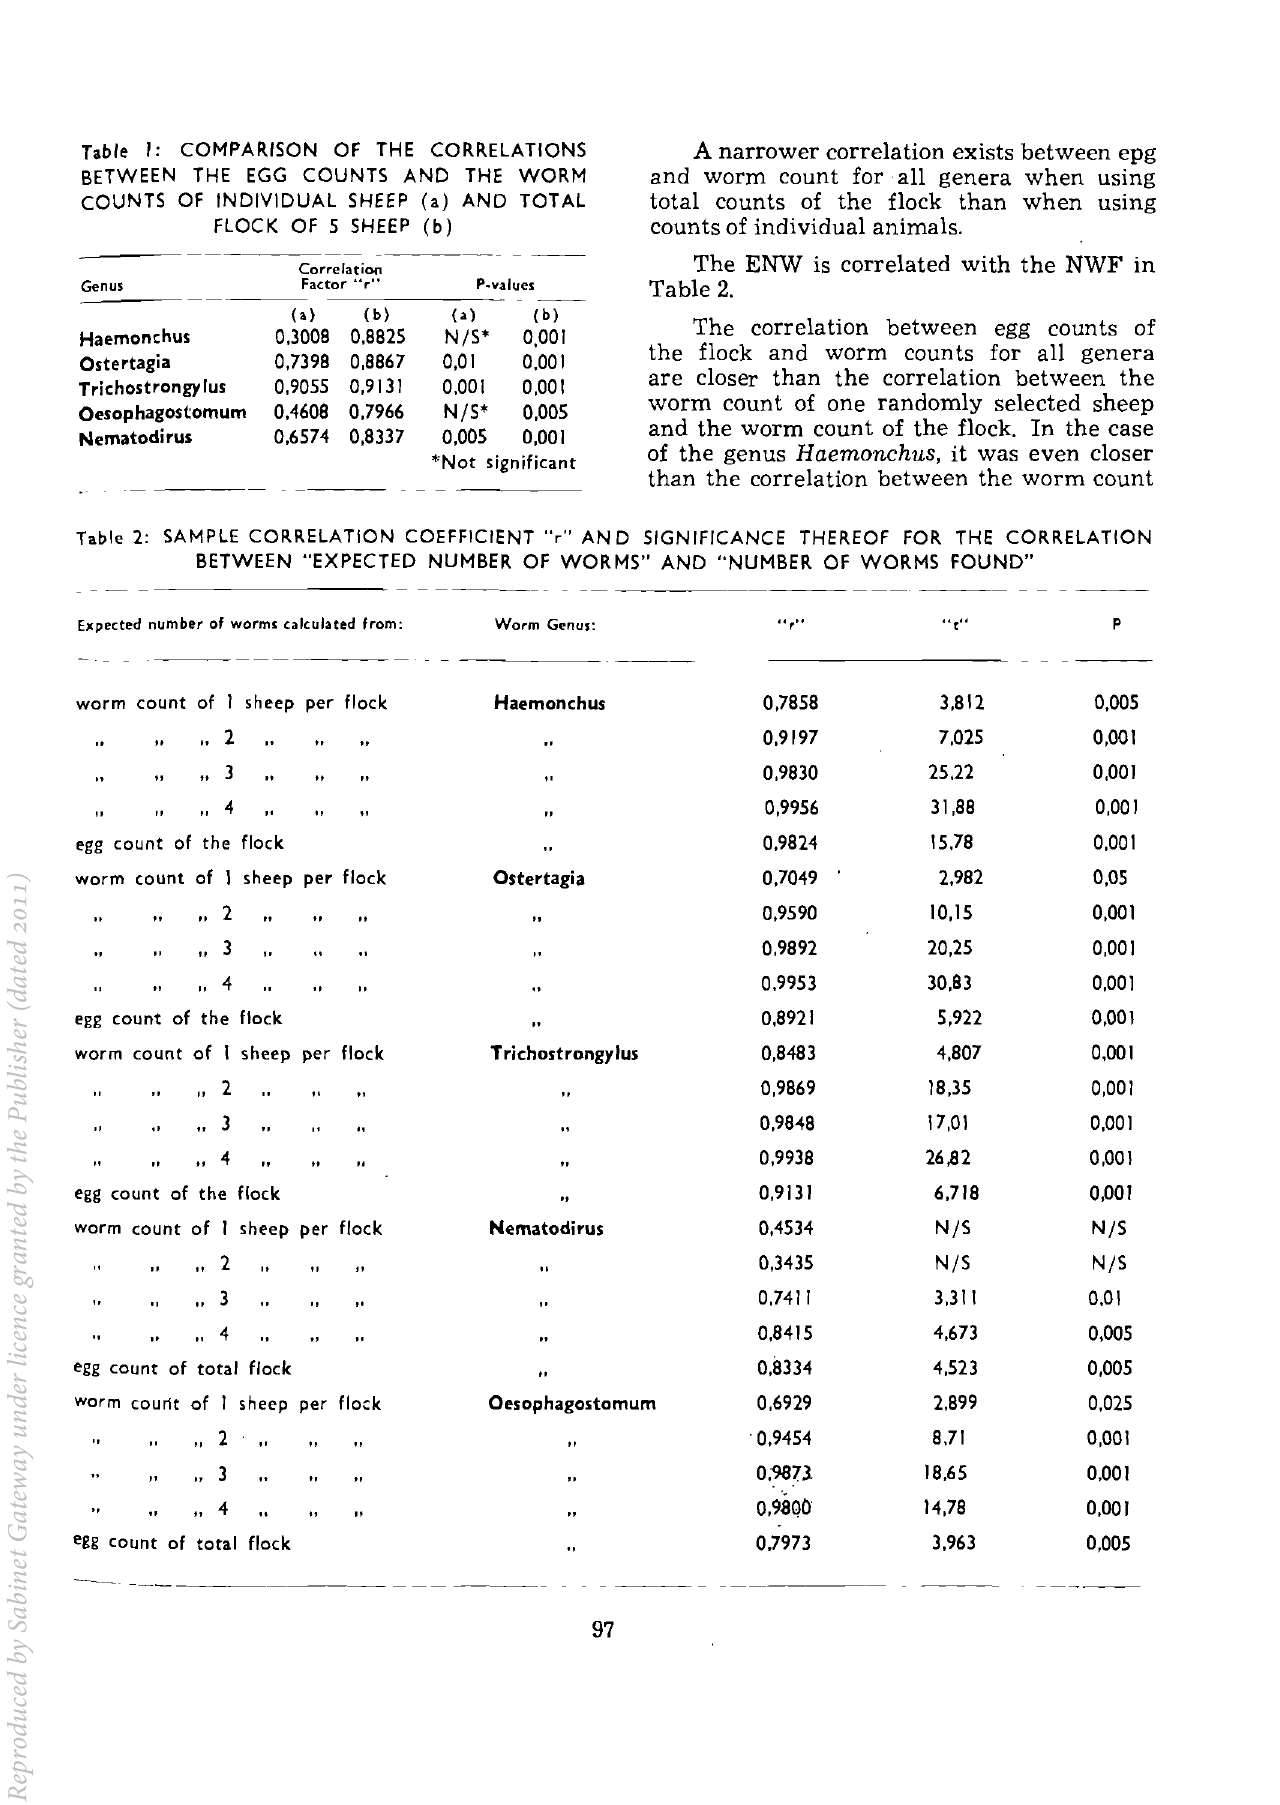
Table I: COMPARISON OF THE CORRELATIONS BETWEEN THE EGG COUNTS AND THE WORM COUNTS OF INDIVIDUAL SHEEP (a) AND TOTAL FLOCK OF 5 SHEEP (b)